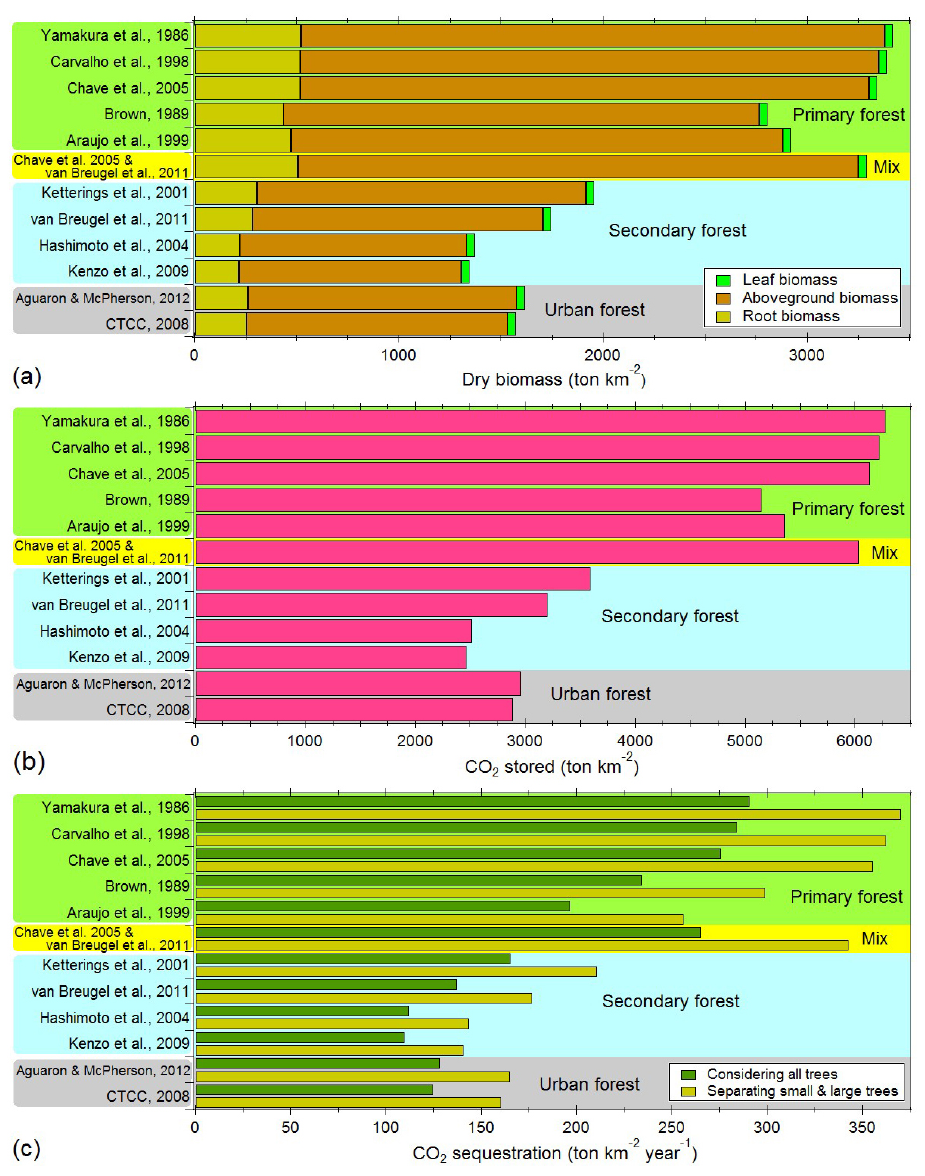
Fig. 4. (a) Dry biomass, (b) CO 2 stored and (c) annual CO 2 sequestration by all woody trees in Telok Kurau calculated from allometric equations and metabolic theory of ecology for different forest habitats. The horizontal bars marked “Mix” correspond to estimations when trees were separated into large and small to calculate their biomass using allometric equations for primary and secondary forests, respec- tively. Biomass production was calculated from Eq. (7) using scaling parameters depending on tree size (i.e. small and large). Annual CO 2 sequestration was calculated as biomass production multiplied by a factor of 1.2 to incorporate other physiological processes associated with carbon